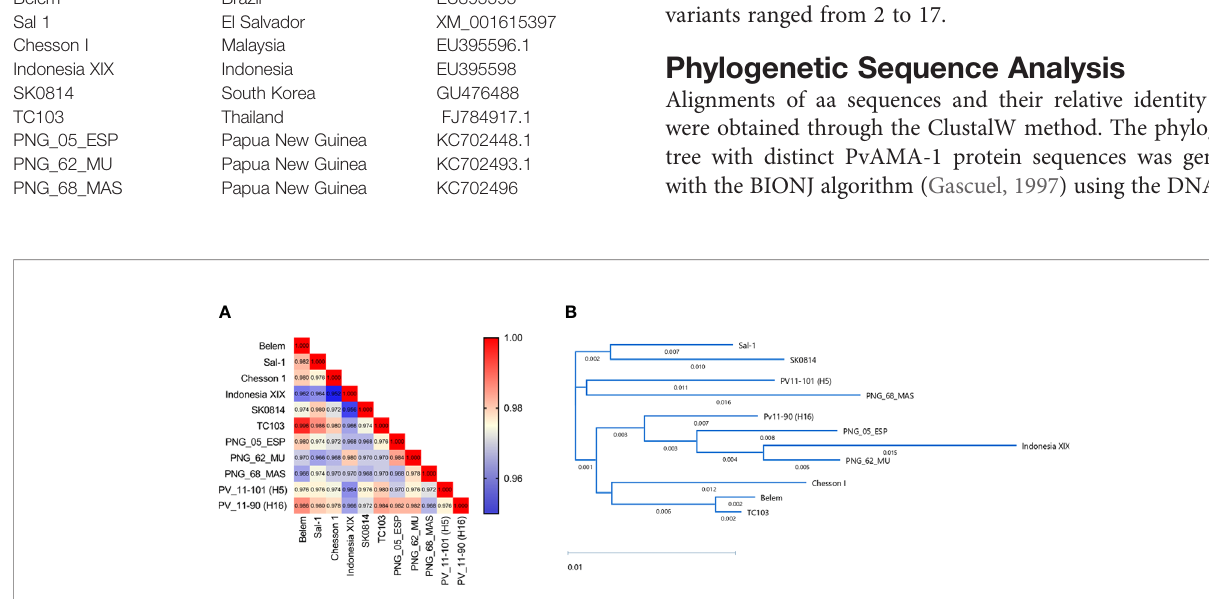
FIGURE 1 | PvAMA-1 protein diversity analysis. The diversity of selected PvAMA-1 sequences from diverse geographical locations was compared among themselves. (A) Heatmap represents the identity scores among the different isolates ranging from 0.95 (blue) to 1.00 (red). (B) Dendogram of the phylogenetic tree obtained from full-length amino acid sequences of PvAMA-1 isolates using the BIONJ